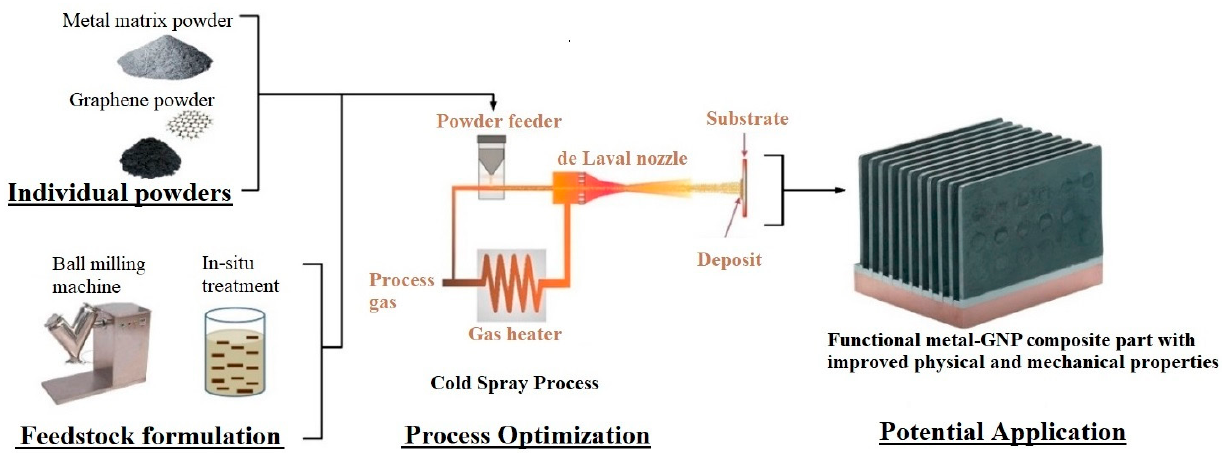
Figure 14. Schematic representing the three research areas to develop metal/GNP cold-sprayed